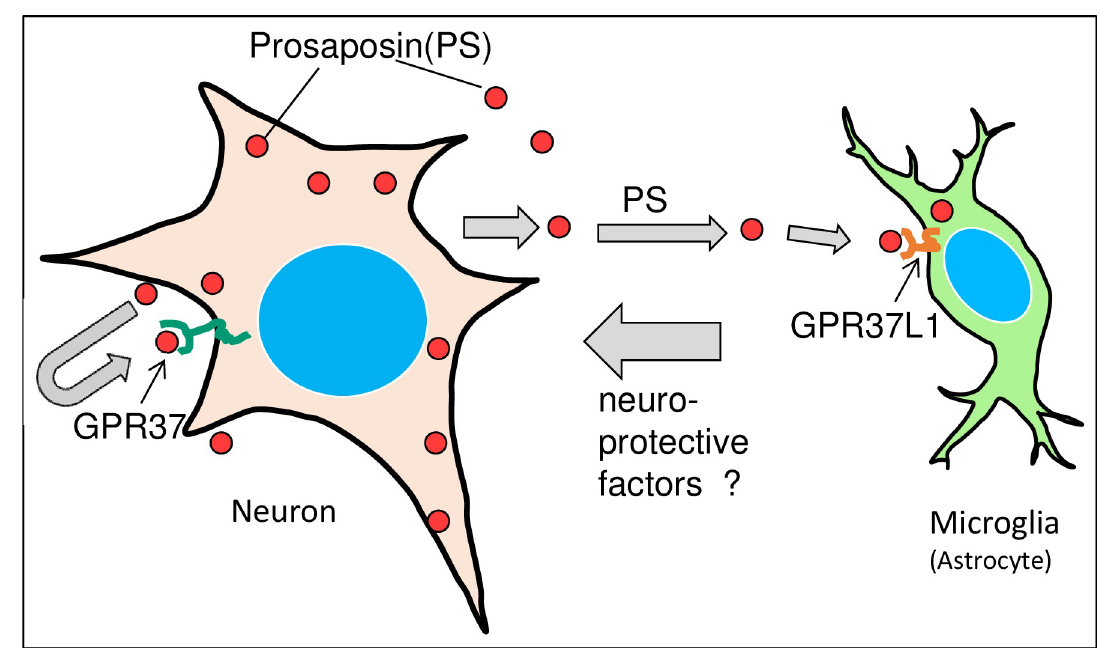
Fig 8. Schematic drawing of the pathological events between neurons and microglia/astrocyte in the facial nucleus after nerve transection. Neuronal damage produces PS, and PS stimulates neuroprotective effects via GPR37. At the same time, secreted PS stimulates microglia or astrocyte via GPR37L1 to produce some neuroprotective factors.